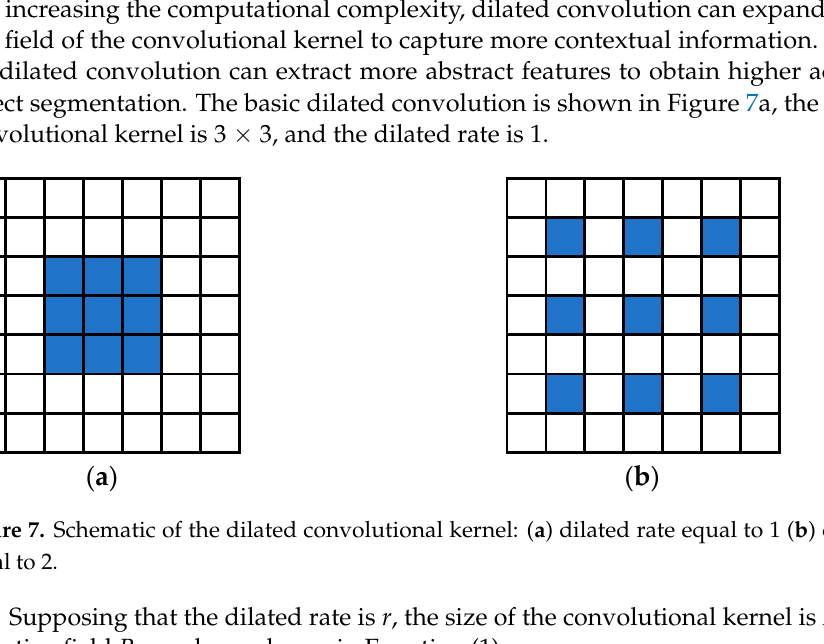
Figure 8. The structure diagram of the Attention Gate.